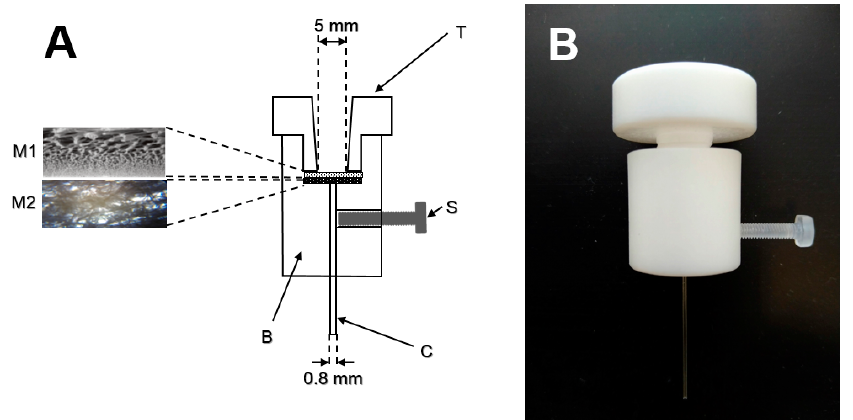
Figure 4. A schematic of the blood plasma separation device ( A ) with the photographs of the membrane structures. A photograph of the assembled device ( B ) .